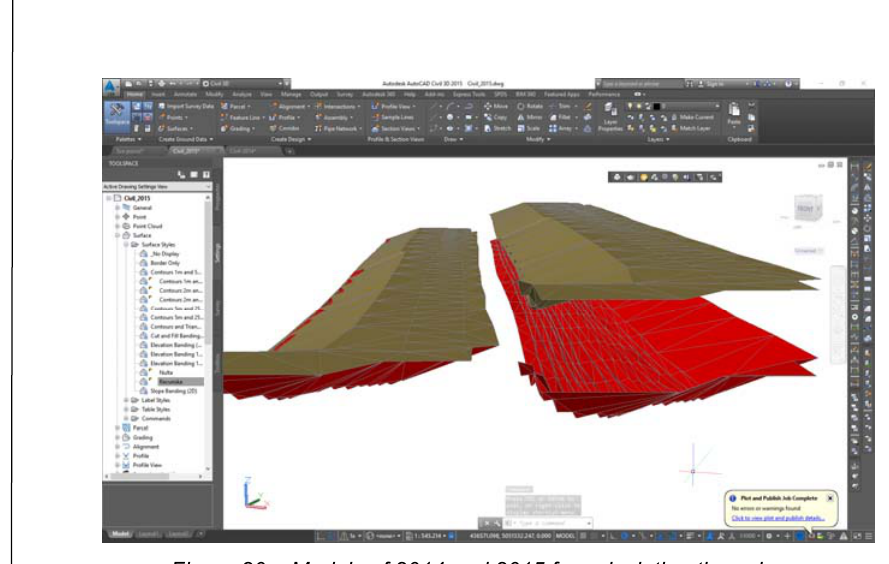
Figure 20 – Models of 2014 and 2015 for calculating the volume Рис . 20 – Модели 2014 г и 2015 г . для расчета